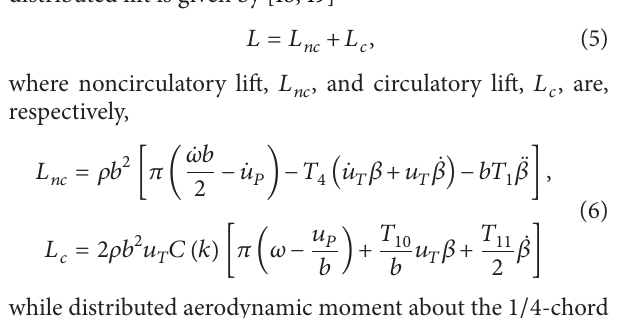
Table 1: Nondimensionalization factors. Physical quantities Scaling